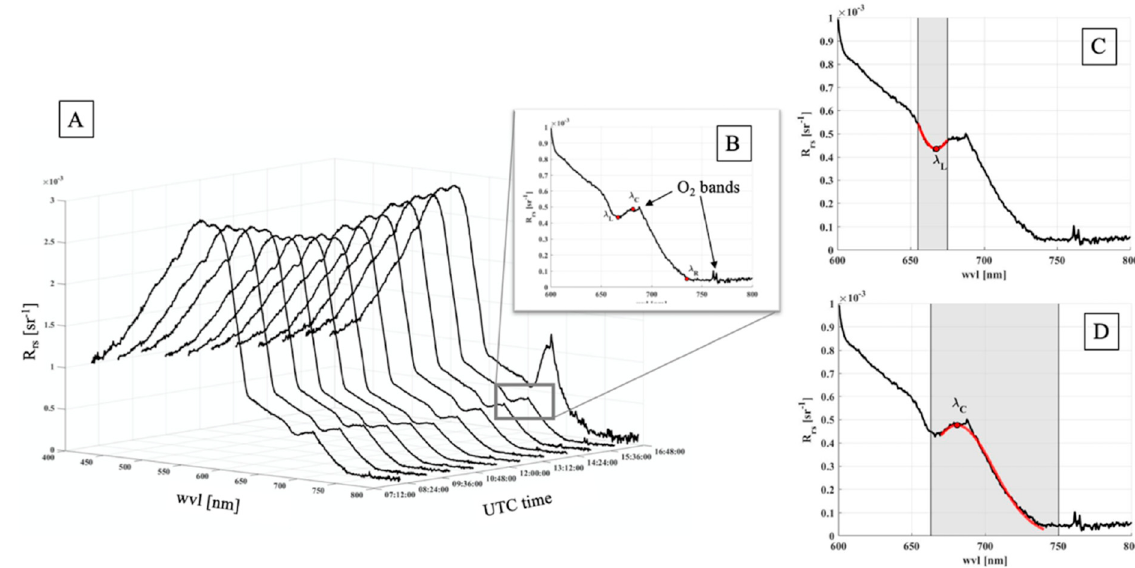
Figure 2. ( A ): times series corresponding to the R rs spectra used to find the wavebands positions. It is clear a change in the spectra shape during the day, especially close to the sunset. ( B ): wavelengths range investigated. The two arrows highlight the artefacts due to the O 2 absorption bands. Red points shown the positions of λ C , λ L λ R , respectively. ( C ): the grey area shows the spectral range in which the λ L has been searched. Red line represents the fit performed. ( D ): similarly, the λ C has been evaluated by means of a gaussian fit (red line).